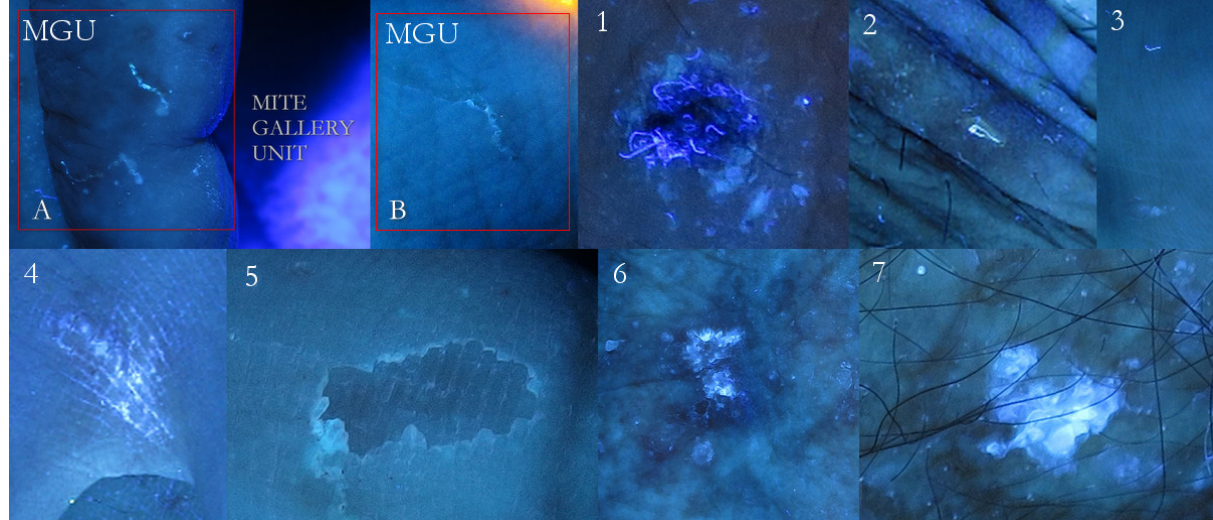
Figure 17. False-positive examples. A mosaic table of possible positive signs compared to Mite-Gallery Units ( A + B ). Fabric threads captured by an erosion ( 1 ). Single thread shinier then any MGU ( 2 ). A thread above, a remnant of burrow down ( 3 ). Bright luminescent exogenous substance contaminating interdigital hand folds ( 4 ). Very superficial erosion as a faint luminescent scalloped collarette ( 5 ). An evident white luminescence of an epidermal keratosis ( 6 ). A very bright white lamellar luminescence of an actinic keratosis ( 7 ). These signs can be found separately or close to specific scabies